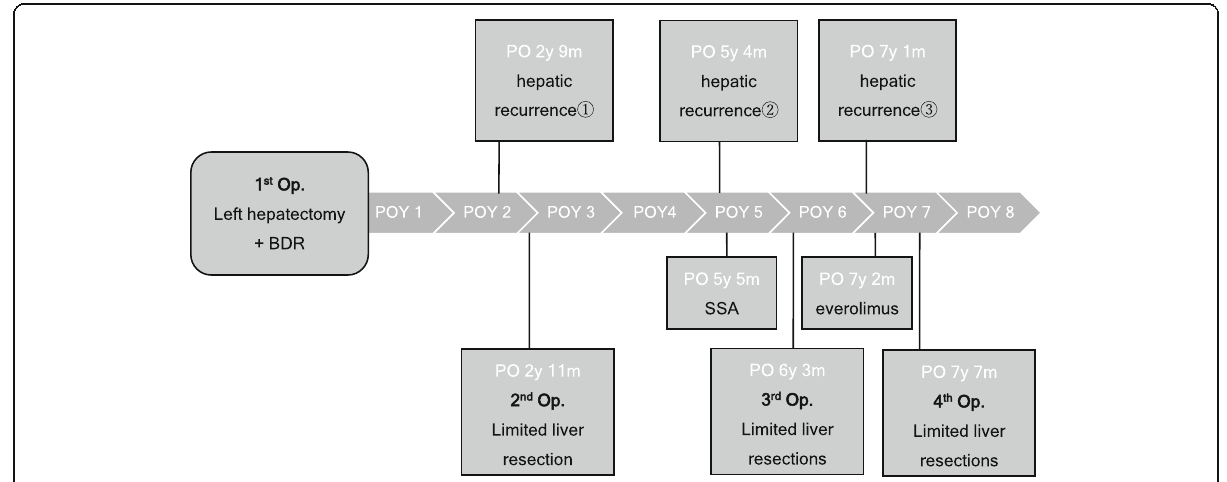
Fig. 6 Chronological progress of the case. Operation was performed four times, and long-term survival of 8 years was